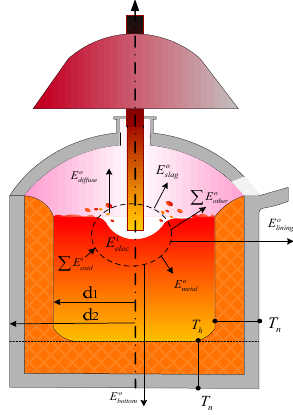
Figure 8. Schematic diagram illustrating heat exchange inside the furnace.